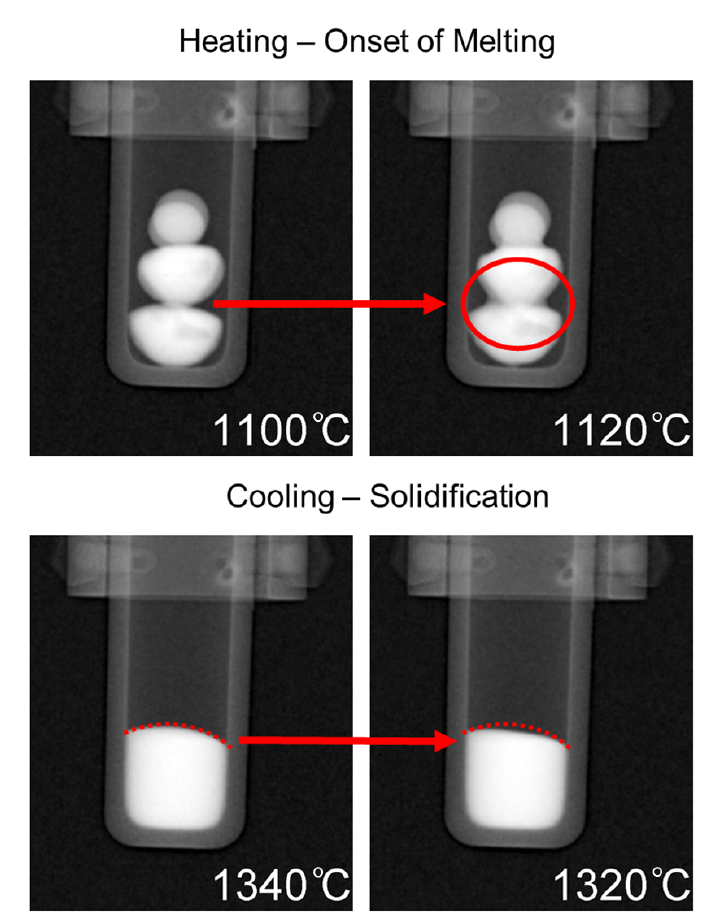
Figure 6. Top: Onset of melting as depicted via the dark phase spreading downwards outlined by a red circle. Bottom: Solidification as indicated by thermal contraction inside the dotted red line. Radiographs taken at different temperatures during the heating process are presented in Figure 7. The buttons are in the solid state at 1000 °C, while the subsequent radiographs show different stages of melting as well as the final temperature of 1500 °C which was held for approximately 35 min